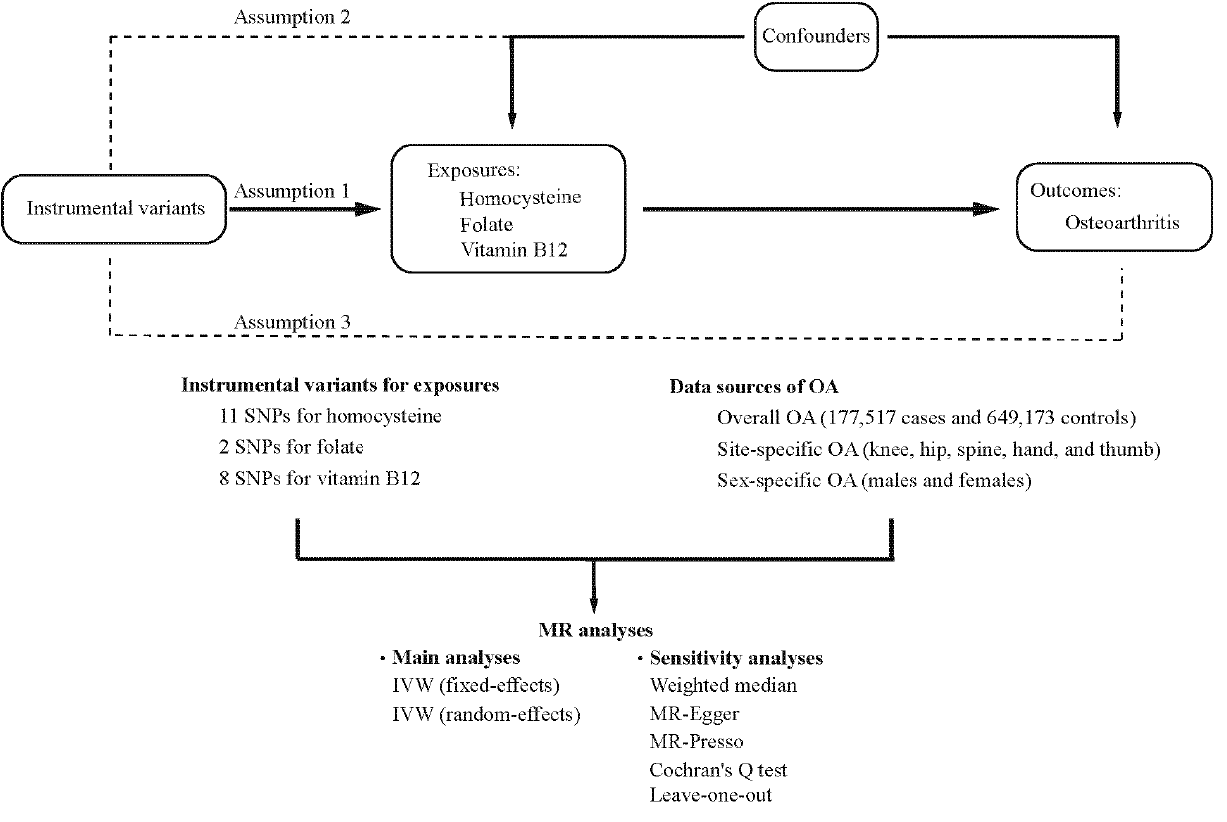
Figure 1. An overview of the study design. SNP: single nucleotide polymorphism; OA: osteoarthritis; MR: Mendelian randomization; IVW: inverse-variance weighted.